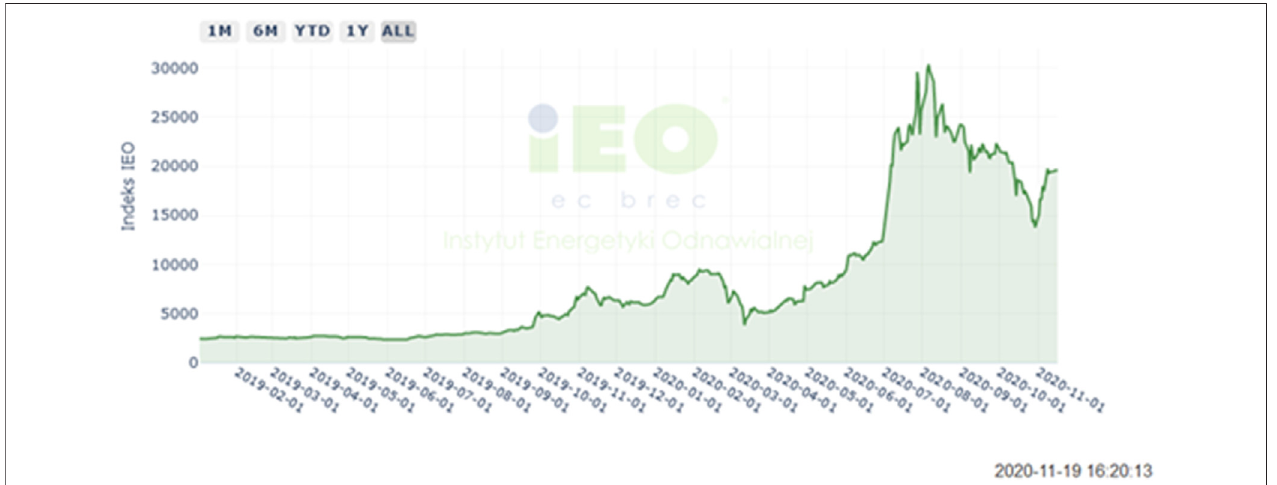
FIGURE 1 | The indicator of the economic situation of the solar collector market in Poland (Ministry of Development,